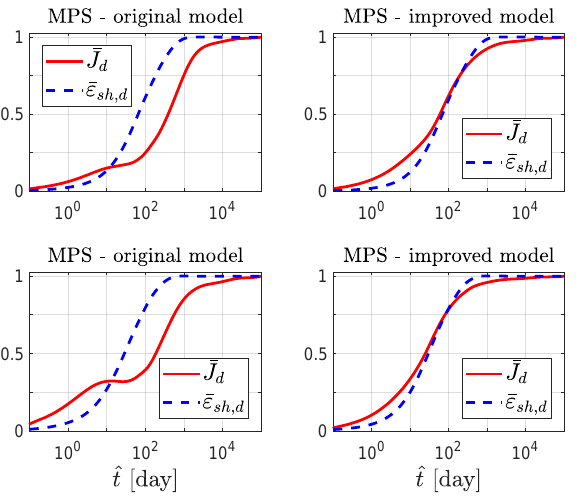
Figure 6. The processed results of FE simulations of Bryant’s experiment showing the time evolution of normalized drying creep and shrinkage. The top two figures are for 150 mm slabs bottom two figures are for 150 × 150 mm prism. The curves are normalized with respect to the ultimate value.